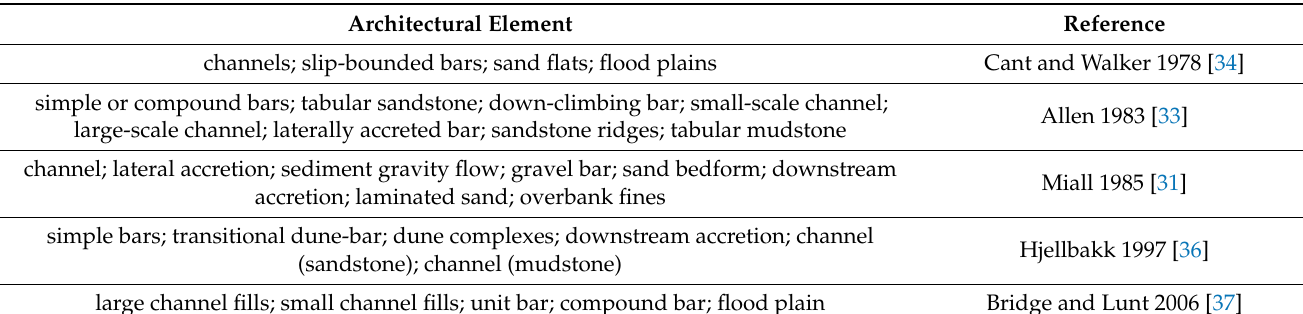
Table 1. Classification of architectural elements of braided river system by different